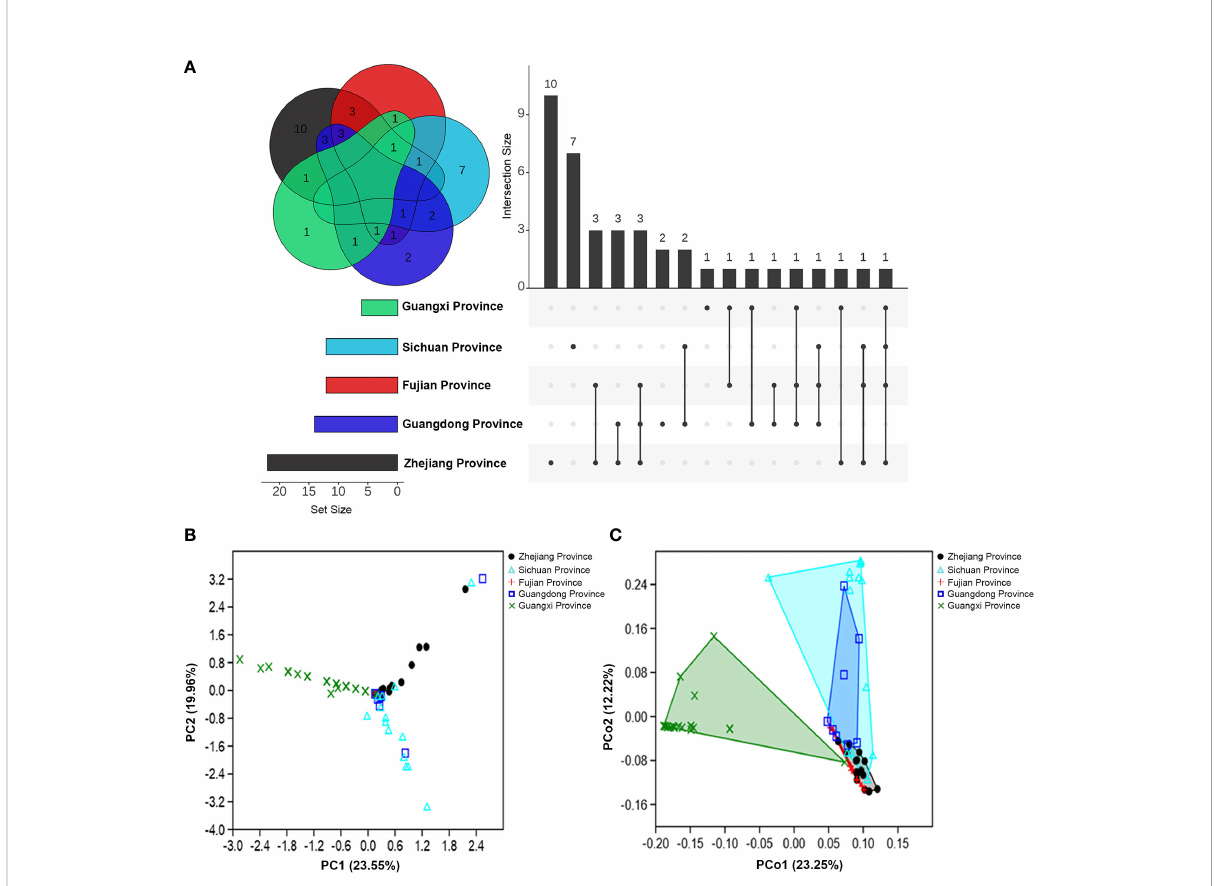
FIGURE 1 Community composition variations of fungal associates of M . alternatus populations from fi ve geographical regions. (A) Venn diagram and upset plot. (B) PCA of Bray-Curtis distance differentiating patterns of samples from different populations according to fungal community composition. (C) PCoA of Bray-Curtis distance showing variation in fungal community composition among geographical